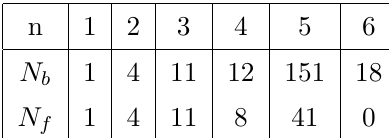
Table 3 . The number of bosonic N b or fermionic N f gauge invariant tensors constructed using n (cid:12)elds. Here N 1 = N 2 = N 3 =